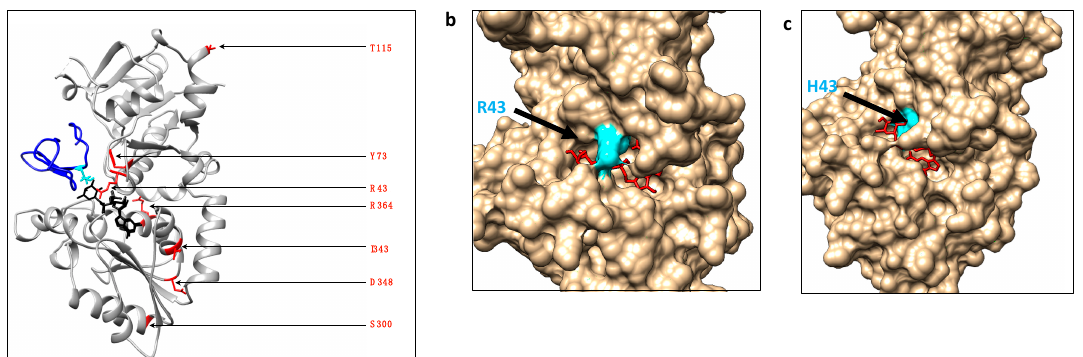
Figure 6. Location of POFUT1 residues mutated in CRC and automatic docking models for WT POFUT1 and R43H variant with GDP-fucose as a ligand. ( a ) Using Matchmaker of CHIMERA, X-ray structure of human POFUT1 (grey) co-crystallized with GDP-fucose (black) (PDB 5UXH) was superimposed with mouse POFUT1 co-crystallized with EGF-LD 26 (blue) (PDB 5KY4). After removal of mouse POFUT1, residues implicated in CRC mutations were shown with their sidechains (red). ( b ) Using the COACH-D docking server, we performed automatic molecular docking using the FASTA sequence of WT human POFUT1 as a template and GDP-fucose (in red) as a ligand (donor substrate). The residue R 43 , located in front of the binding pocket to GDP-fucose, was colored in cyan. ( c ) In the same way, a structural model was generated for mutated POFUT1 in which the H43 moved to a more deeply buried position in the binding pocket of GDP-fucose, compared to R43 in WT POFUT1. This could lead to a more exposed fucose moiety of the donor substrate to improve fucose transfer to an